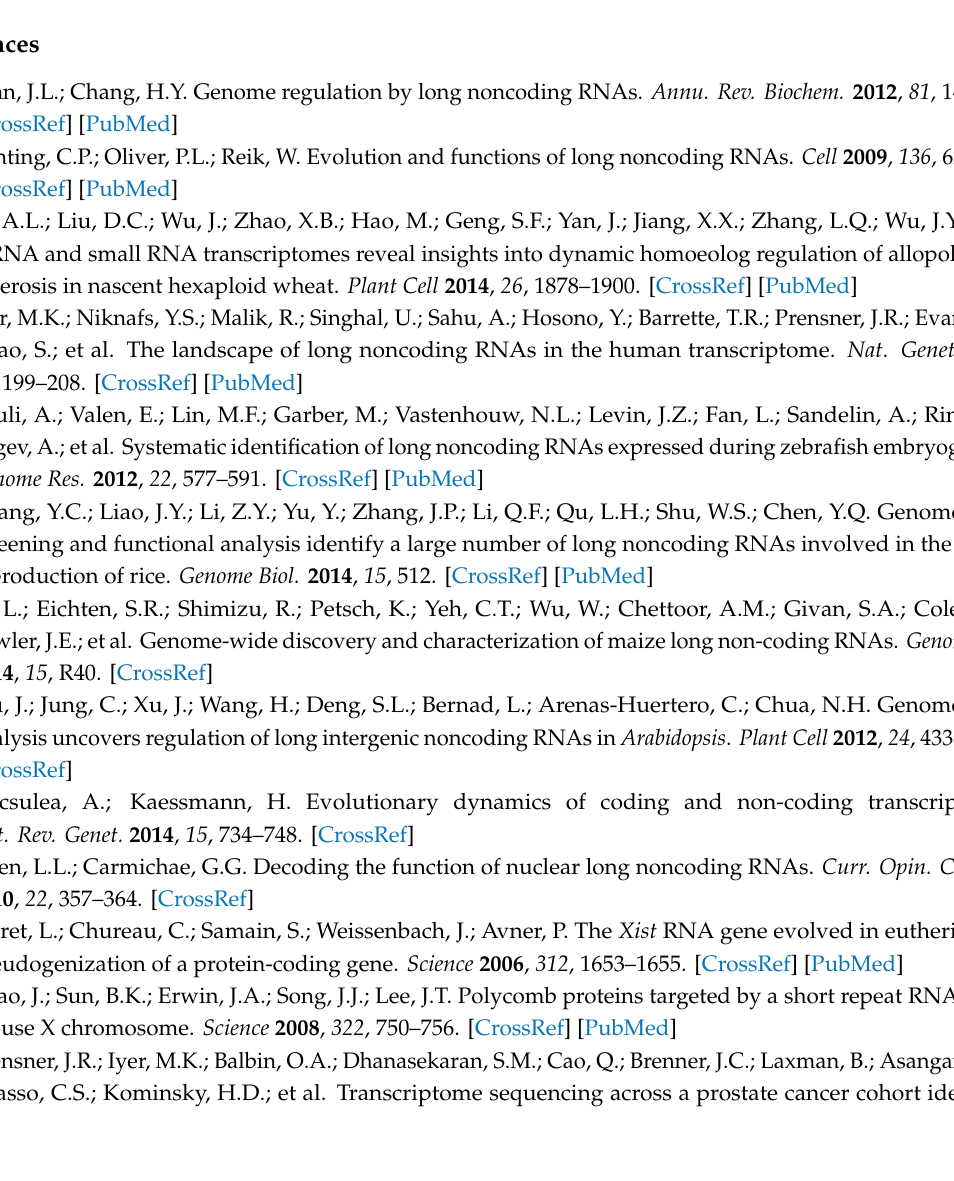
queries. Figure S9: The number of di ff erentially expressed lncRNA genes detected in F 1 hybrid and allotetraploid S 14 progeny compared with diploid progenitors (MPV). Figure S10: GO enrichment analysis of PTGs of di ff erently expressed lncRNAs in F 1 hybrid compared with parents / MPV. Figure S11: Heat maps of lncRNAs and PTGs expression in F 1 hybrid, allotetraploid S 14 and their parents (HH, CC). Figure S12: Photosynthetic characterization of the three species about allotetraploid S 14 and their parents (HH, CC). Table S1: Sequences of qRT-PCR primers. Table S2: The number of lncRNAs and gene overlapping with or without TEs. Table S3: Basic summary of the expression levels of lncRNAs and mRNAs. Table S4: Seven bins of MPV-F 1 -S 14 expression profile of lncRNAs. Table S5: Annotation of potential target genes of lncRNAs involved in photosynthesis. Table S6: E ff ect of allotetraploidization on the expression of lncRNAs and their targets involved in photosynthesis. Table S7: Plant growth characteristics among the C. hytivus and diploid